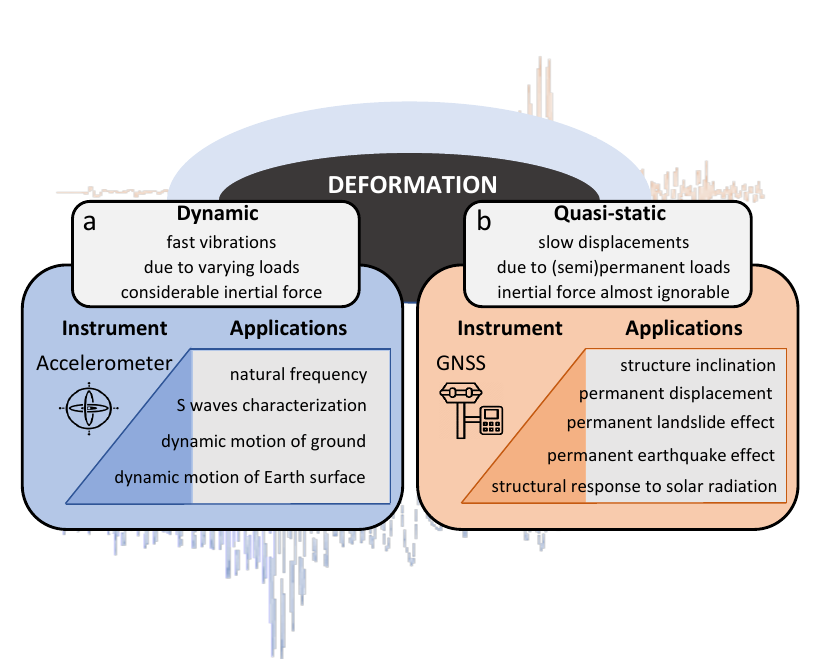
Figure 1. Displacement types: ( a ) dynamic and ( b ) quasi-static, their preferred tracking instruments and corresponding applications. Note the color choice for the two sensor types, blue for accelerometer and red for the Global Navigation Satellite System